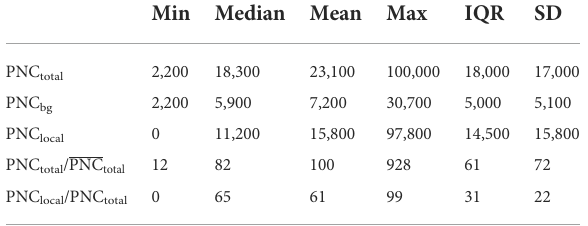
TABLE 2 Overview over all measurement data for PNC total [cm − 3 ], background PNC bg [cm − 3 ], and local concentrations PNC local [cm − 3 ] as well as the ratios PNC total /PNC total [%] and PNC local /PNC total [%], showing minimum, median, arithmetic mean, maximum, interquartile range (IQR), and standard deviation (SD).